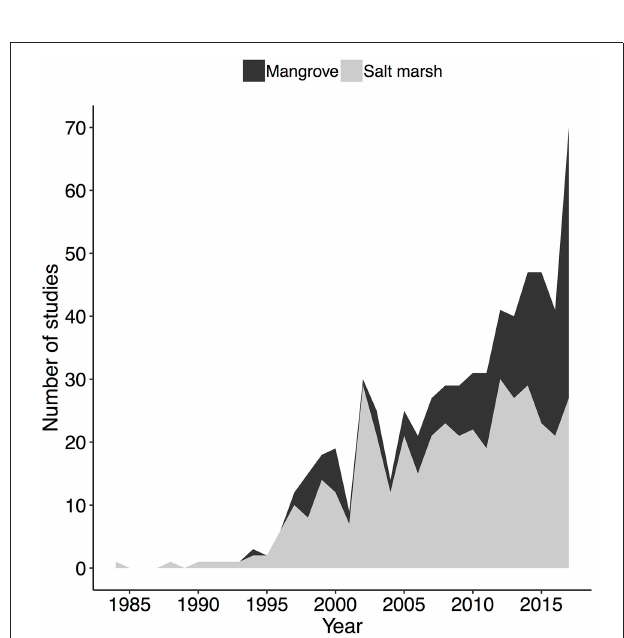
FIGURE 5 | The number of studies from 1980 to 2017 that examined salt-marsh or mangrove restoration. Studies that examined both mangroves and salt marshes were included in both